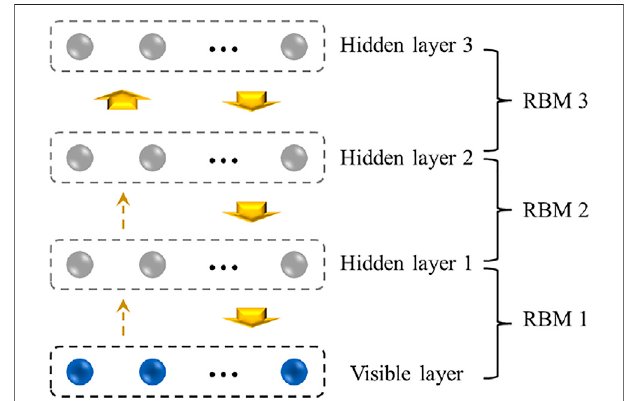
FIGURE 2 | Architecture of the deep belief